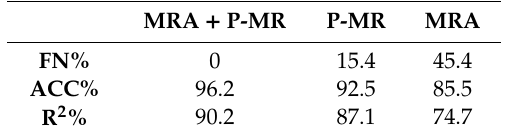
Table 5. Predictive power indicators depending on the analyzed range of data. MRA + P-MR P-MR MRA FN%